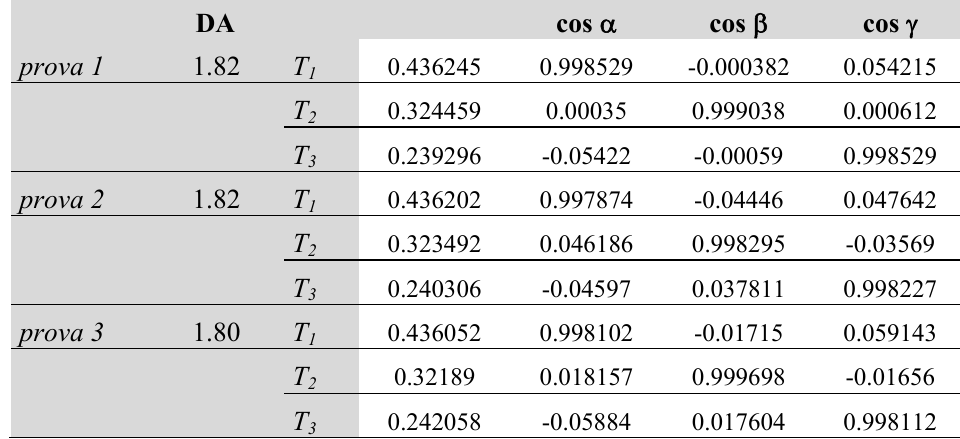
Tabella 2 – Influenza della rotazione random iniziale (griglia di misura con 513 orientazioni e 1000